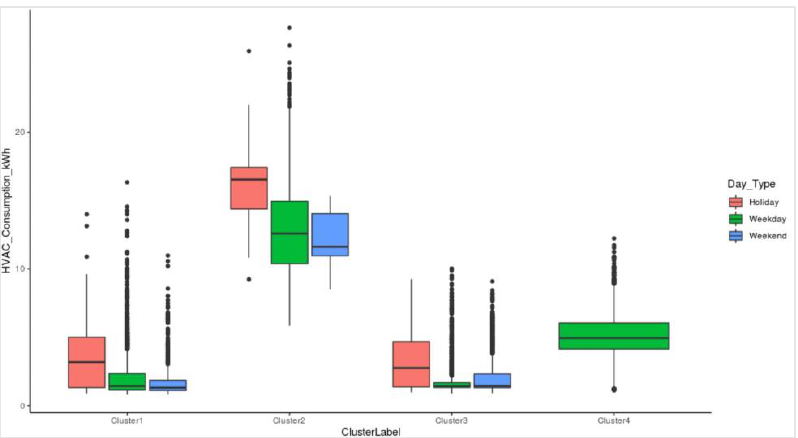
Figure 14. Second-time SOM-generated clusters.